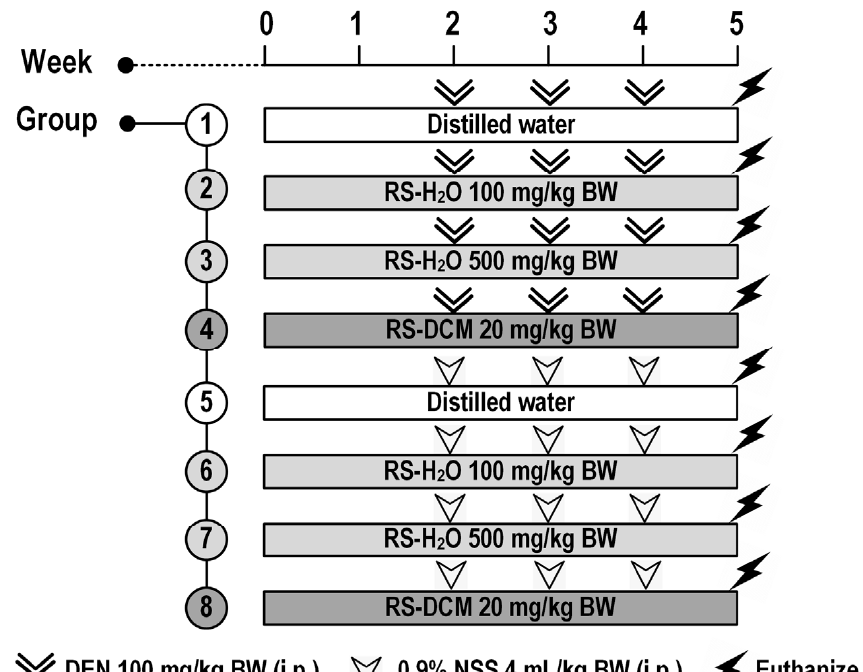
Figure 1. Experimental design to determine the chemopreventive properties of RS in DEN-induced rats. BW: body weight; DEN: diethylnitrosamine; NSS: normal saline solution.